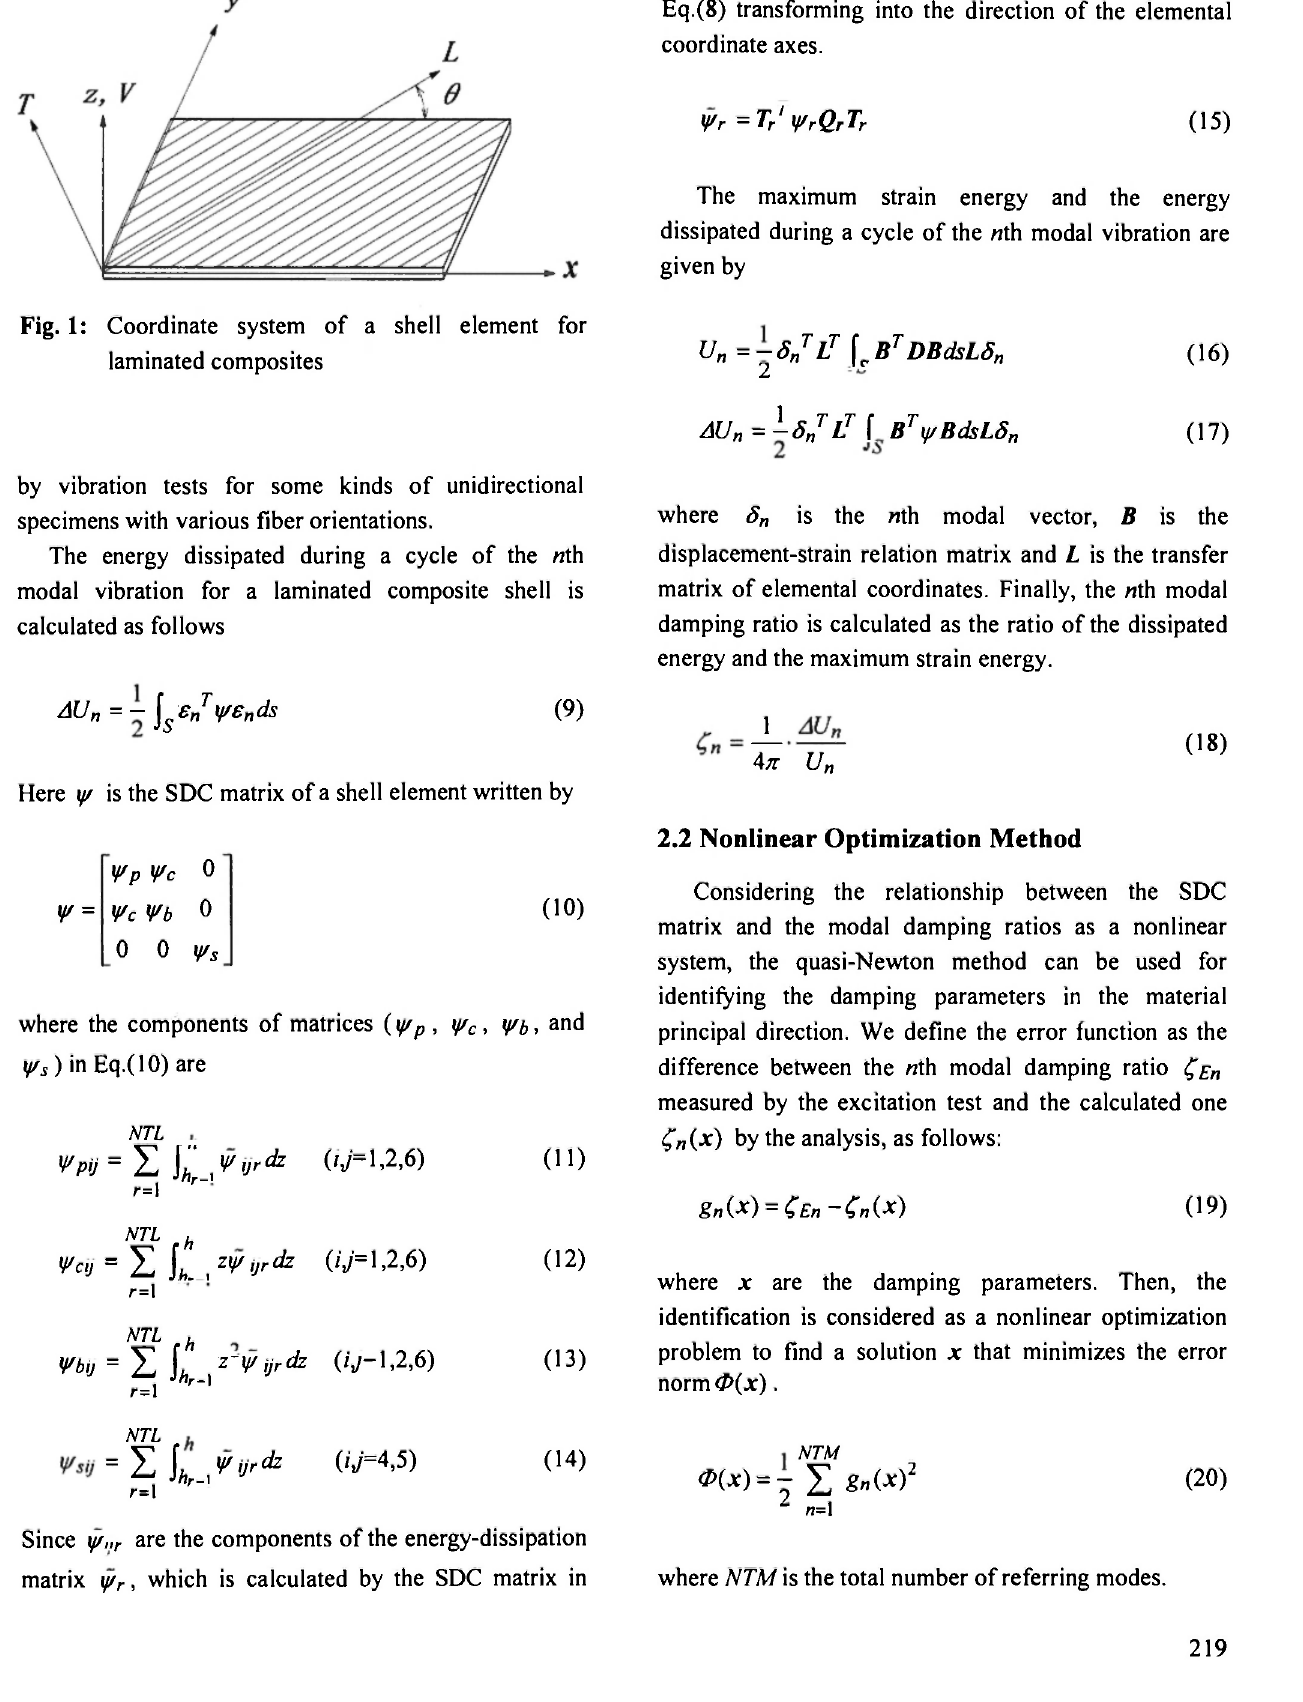
Fig. 1: Coordinate system of a shell element for laminated